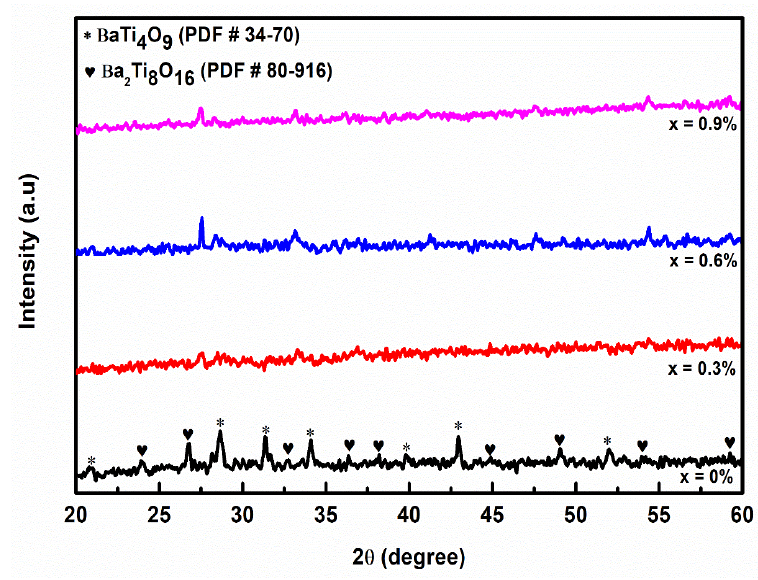
Figure 1. XRD pattern of (Ba 1 − x Ca x )Ti 4 O 9 (x = 0.0, 0.3, 0.6 and 0.9) ceramics powders calcined at 900 °C in air [13].